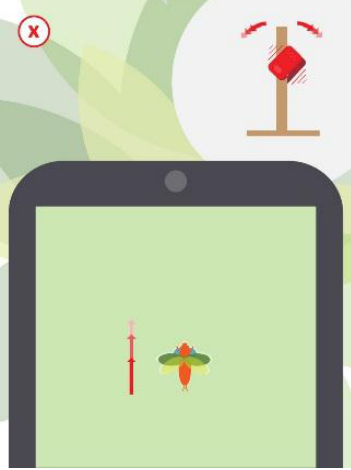
Figure 10. Screenshot of the video game Moskis.